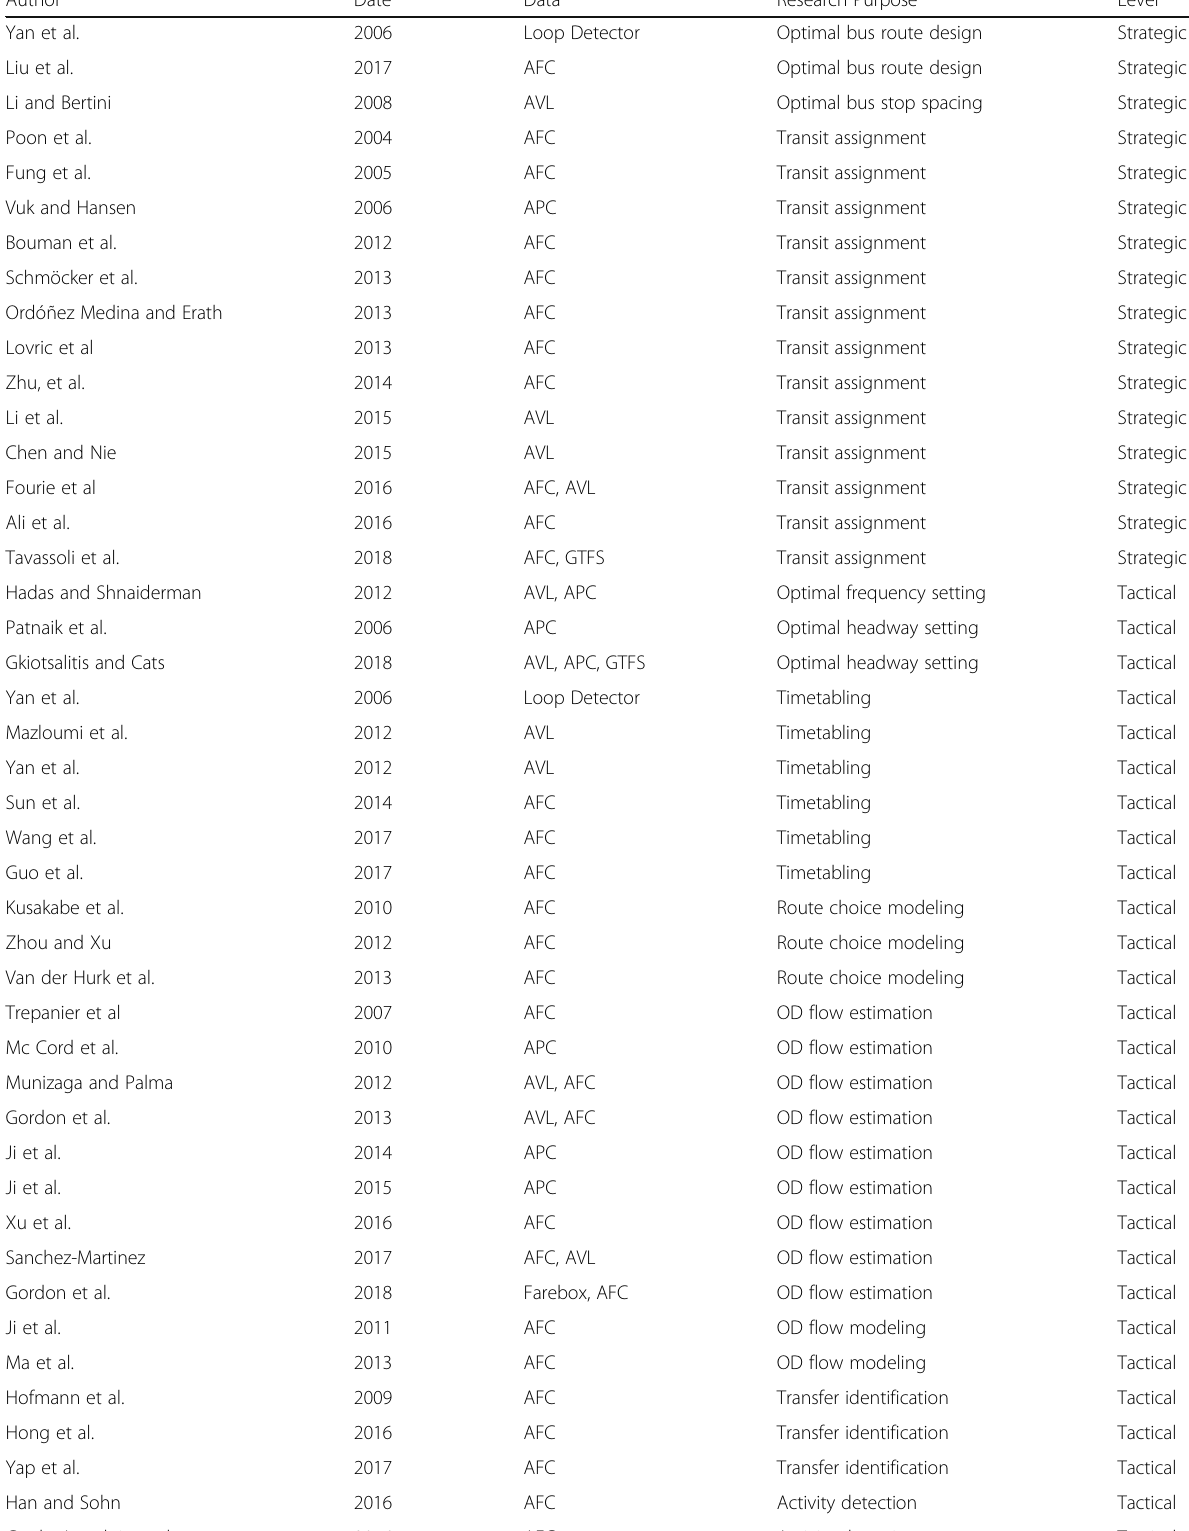
Table 1 Overview of studies using ITS data by research purpose and planning